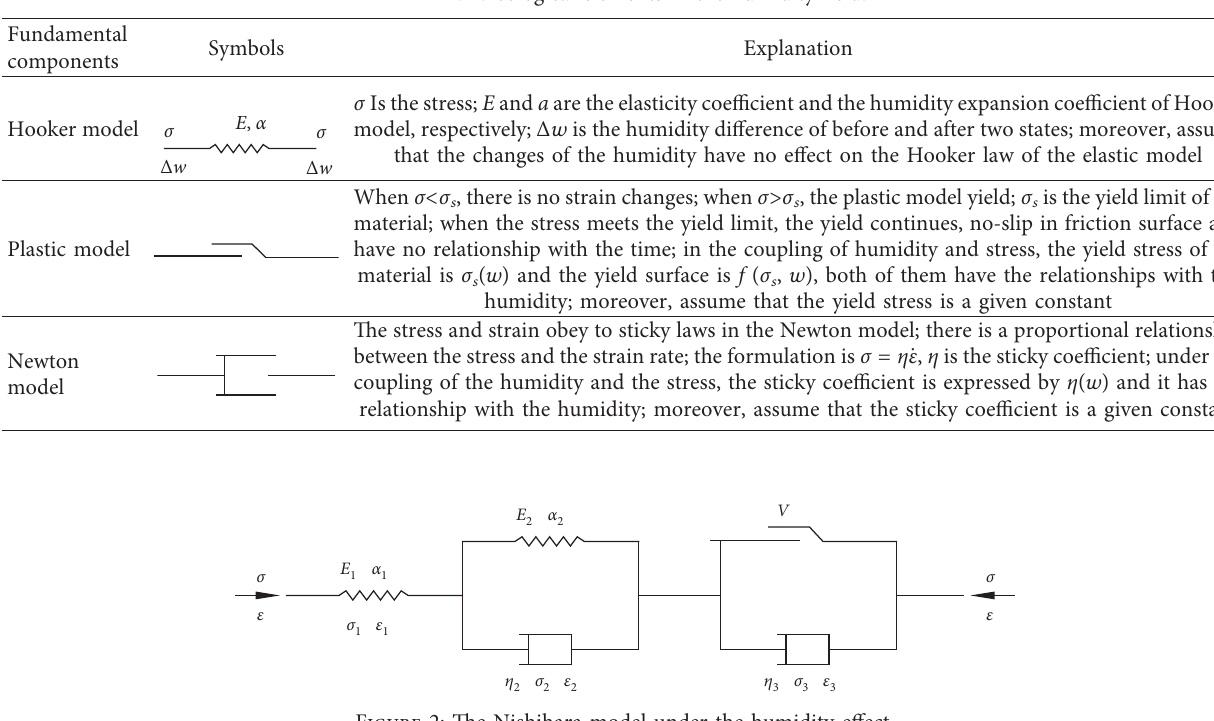
Figure 1: Relationship between expansion strain and water content. Table 2: Rheological elements in the humidity field.